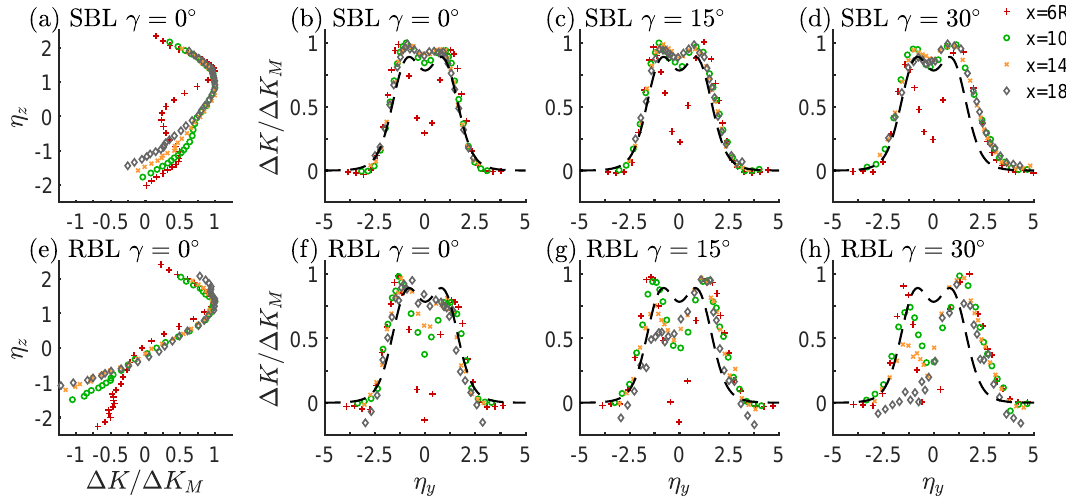
Figure 12. Vertical and lateral profiles of the normalised added turbulent kinetic energy ∆ K / ∆ K M versus η z and η y in the wake of the model wind turbine immersed in the SBL with ( a )/( b ) γ = 0 ◦ , ( c ) γ = 15 ◦ , ( d ) γ = 30 ◦ and in the RBL with ( e )/( f ) γ = 0 ◦ , ( g ) γ = 15 ◦ , ( h ) γ = 30 ◦ . The legend indicates the downstream